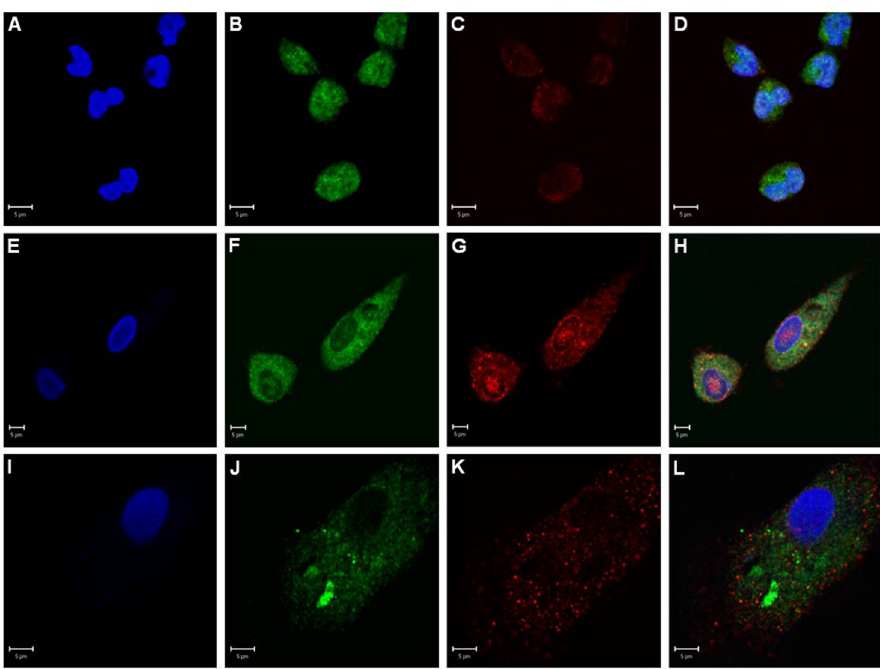
Figure 4. In vitro cultured monocytes, macrophages and foam cells express CD100. Immunofluorescence of PB monocytes (A-D), macrophages (E-H) and foam cells (I-L) showing blue nuclei in DAPI (A, E, I), CD68 ( green ; B, F, J), CD100 ( red ; C, G, K) and co-localization of all markers in D, H and L. Scale bars: 5µm. doi: